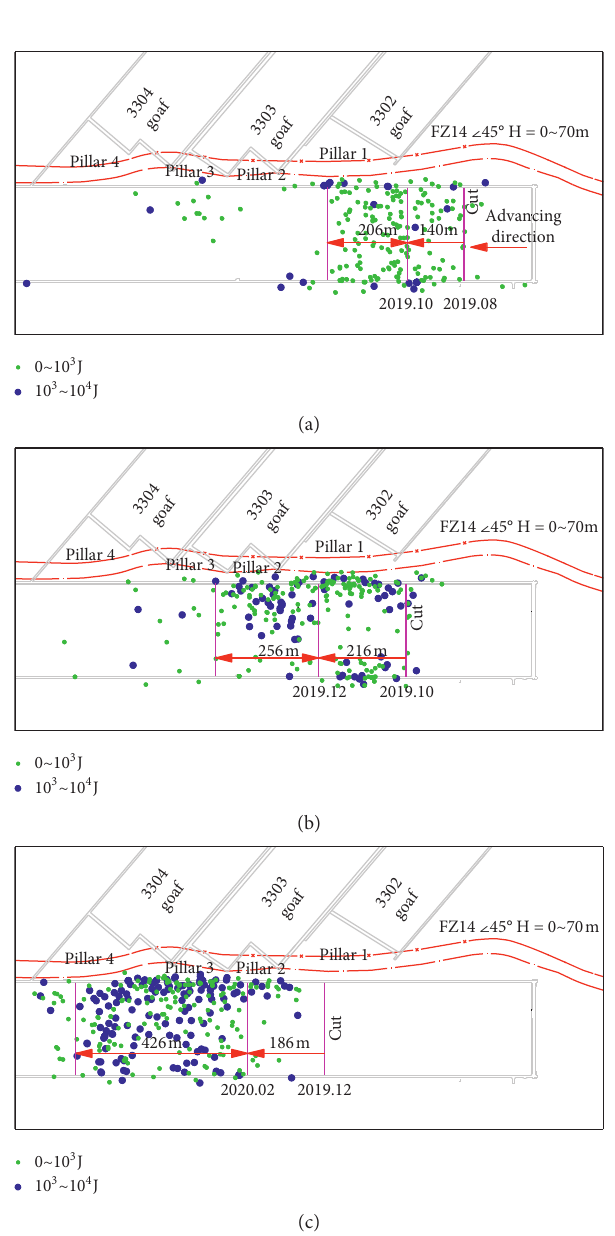
Figure 10: The MS sources location from August 2019 to February 2020. (a) Sources location before entering under the pillars from August to October 2019. (b) Sources location whenadvancing under the pillar 1 from October to December 2019. (c) Sources location whe- nadvancing under the pillar 2 from December 2019 to February 2020.